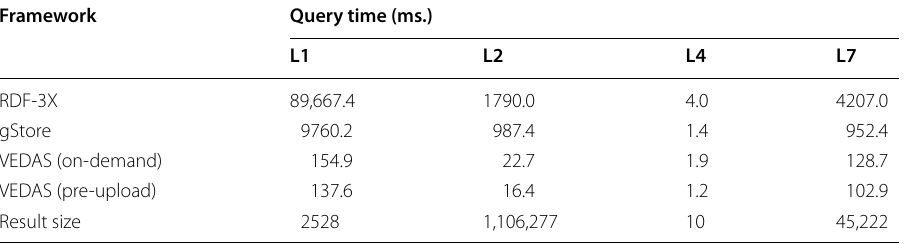
Table 9 Query time for LUBM benchmark of RDF-3X, gStore and VEDAS in milliseconds Framework